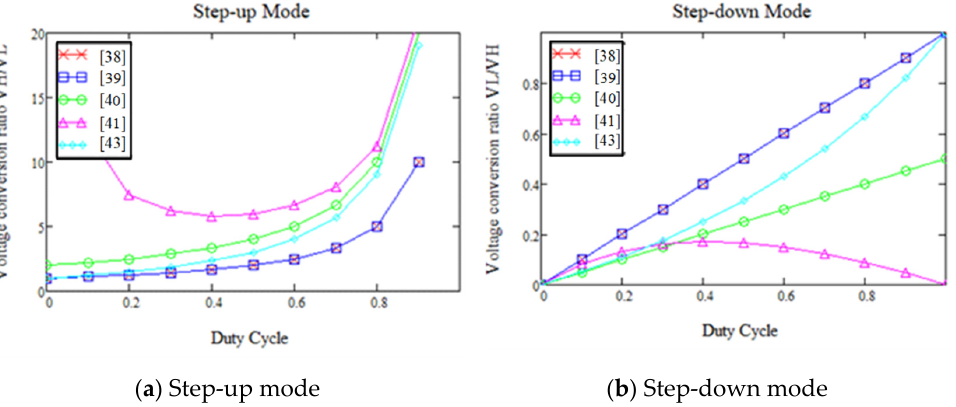
Figure 7. Comparison of voltage-conversion ratios of nonisolated bidirectional DC–DC converters [38–41,43].